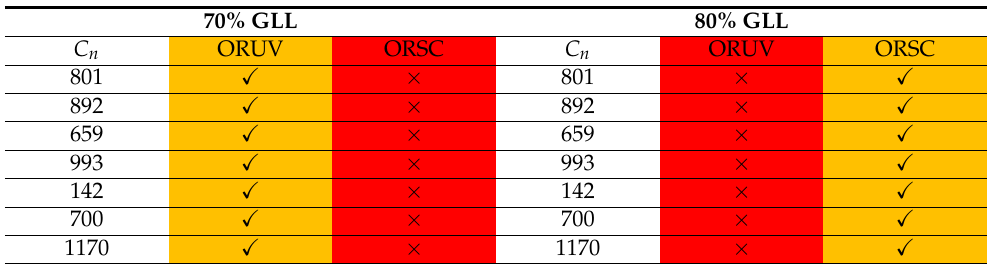
Table 2. ORUV: Contingency comparison under two operating conditions, where the yellow color indicates that these contingencies are contributing to the operational risk and the red color that they are not